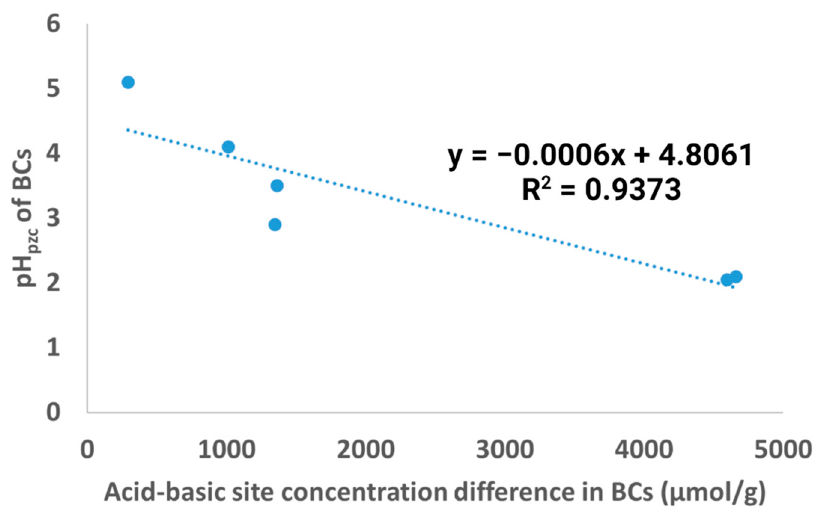
Figure 5. Correlation between the difference in acidic-basic site concentration and pH pzc of biochar samples.